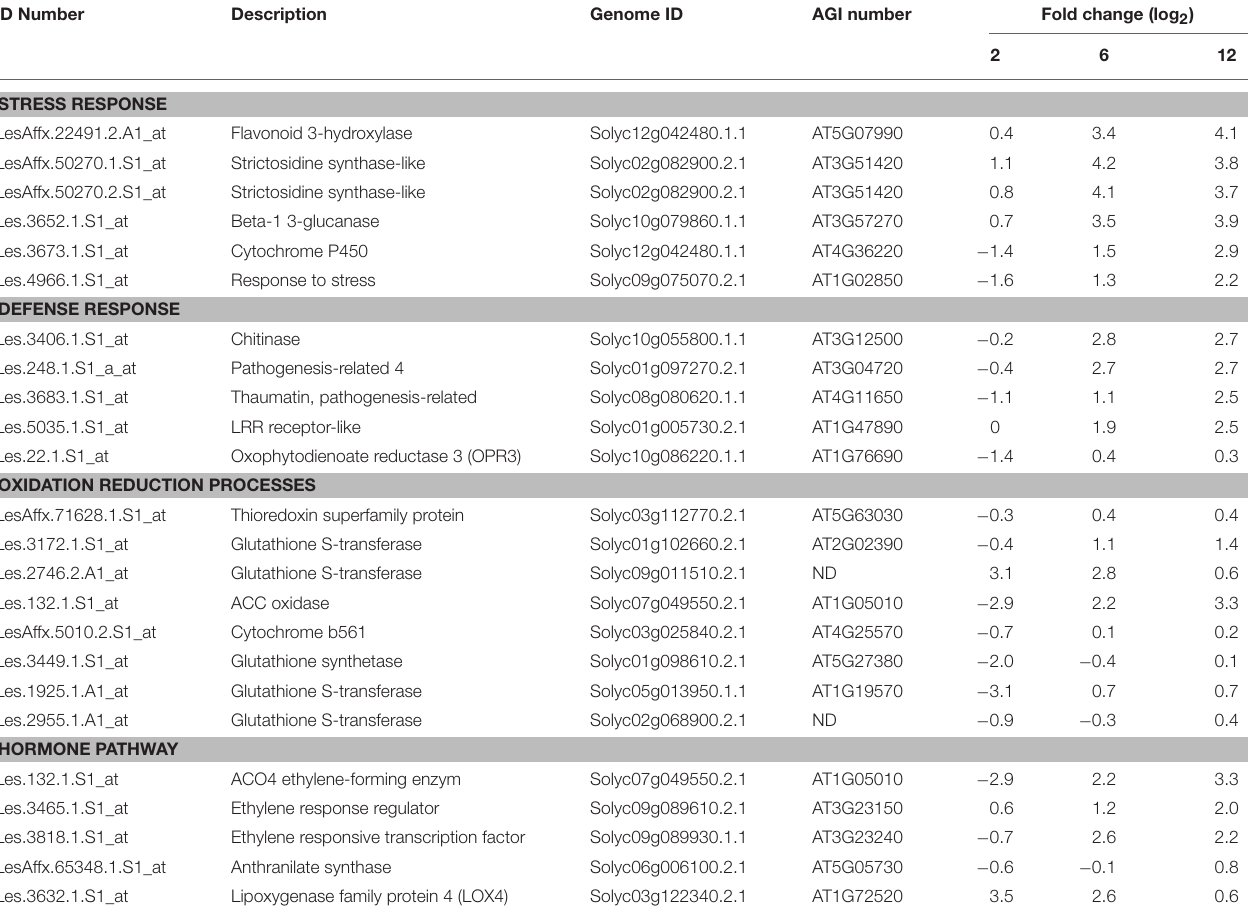
TABLE 1 | Expression profile of defense related genes in response to B. cinerea infections under different N